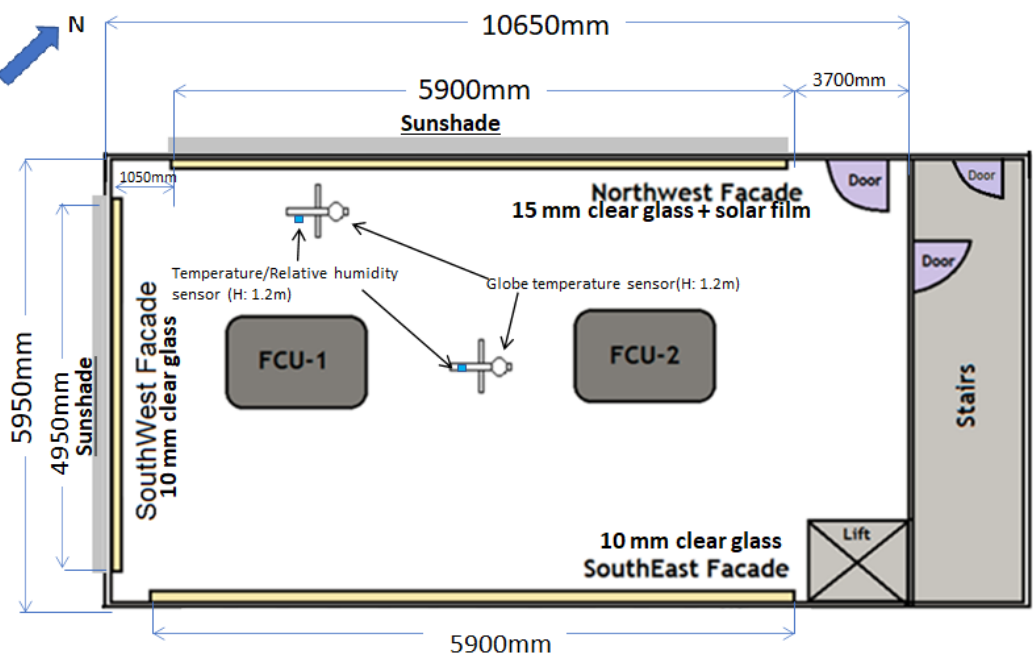
Figure 2. Schematic of room used for test-bedding.